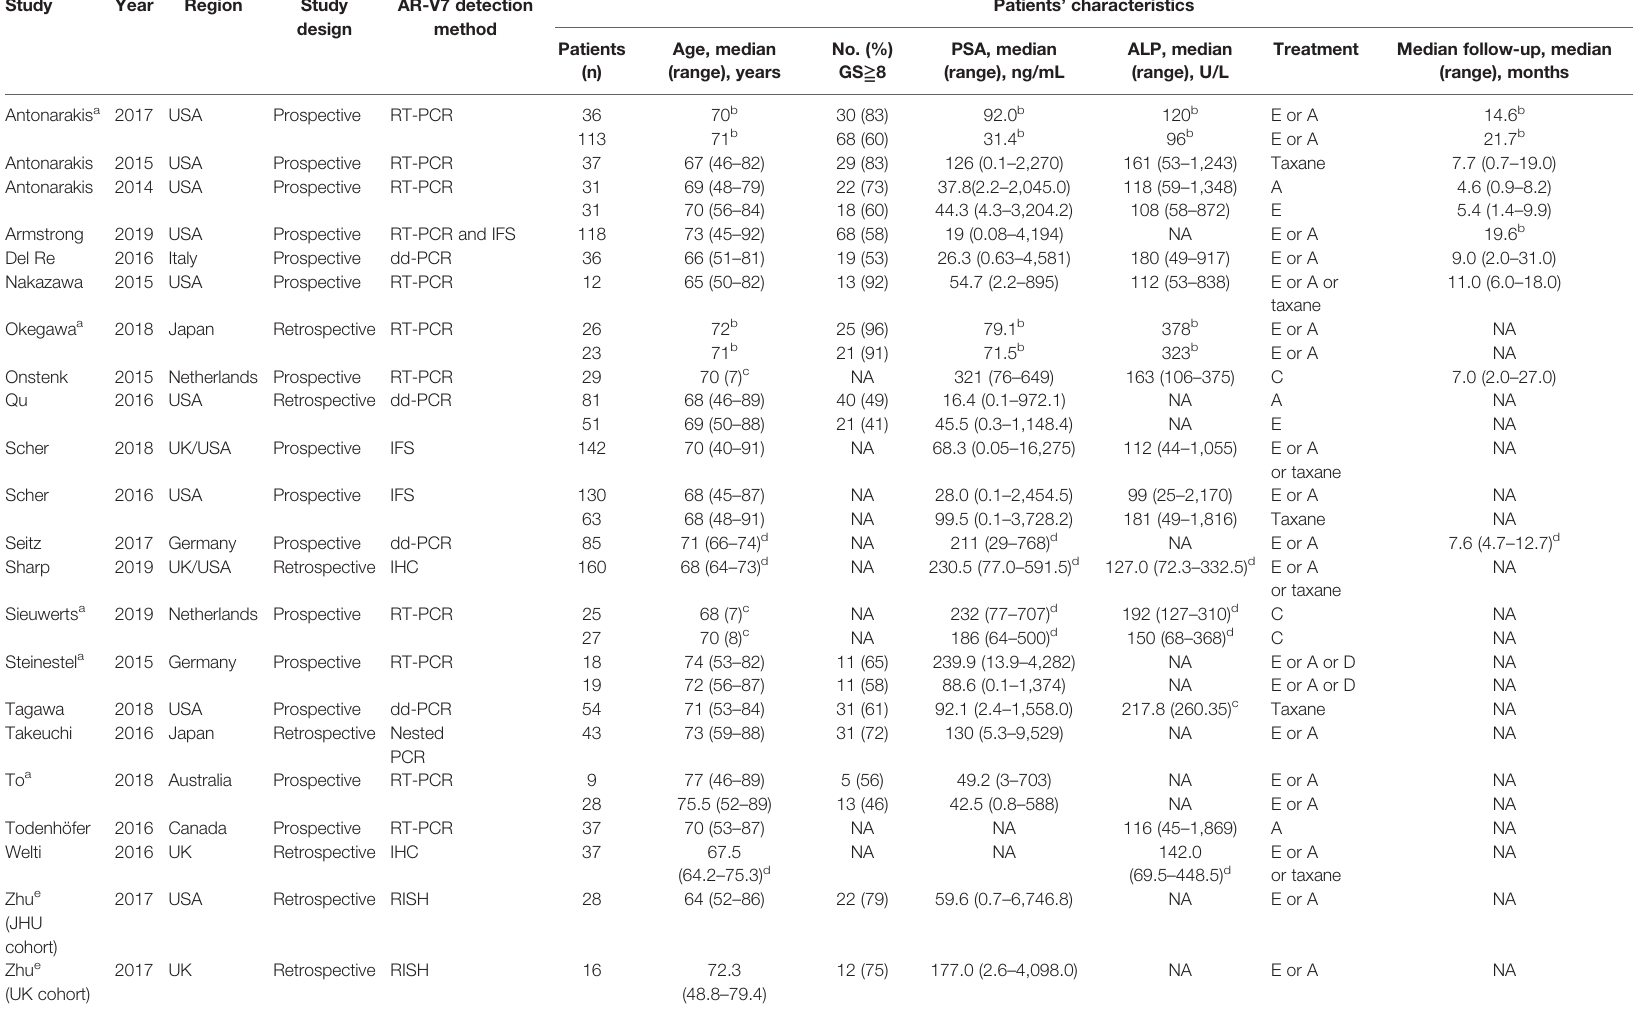
TABLE 1 | Characteristics of included studies and